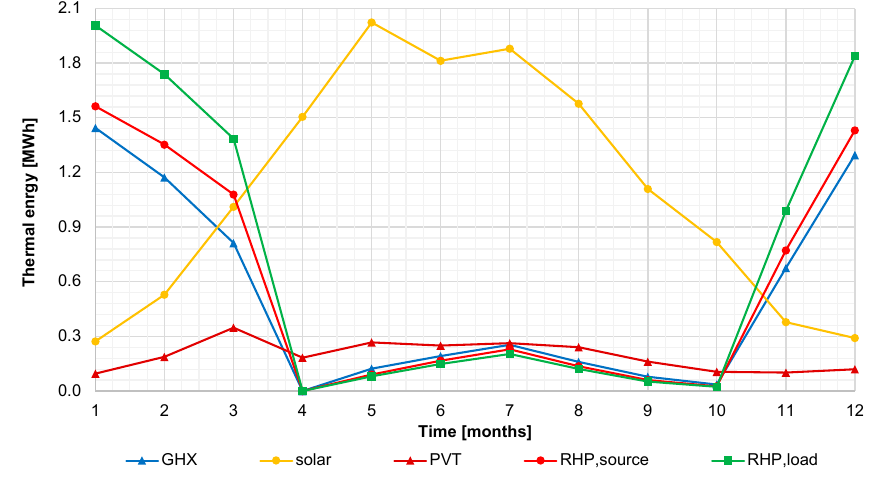
Figure 9. Main thermal energies of the system, monthly analysis.